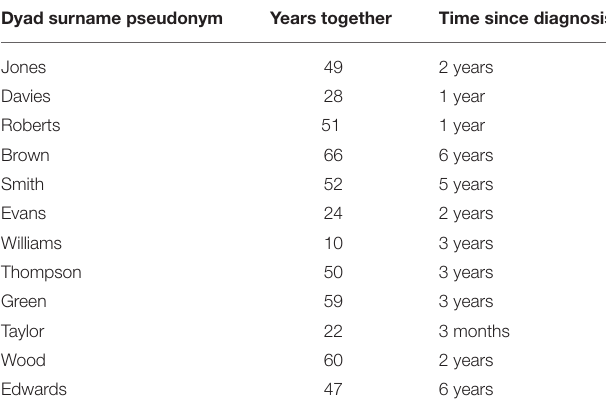
TABLE 2 | Participant